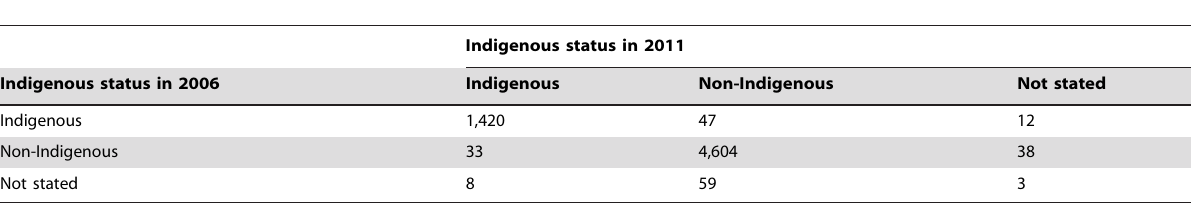
Table 1. Changes to reported Indigenous status between 2006 and 2011, Northern Territory.